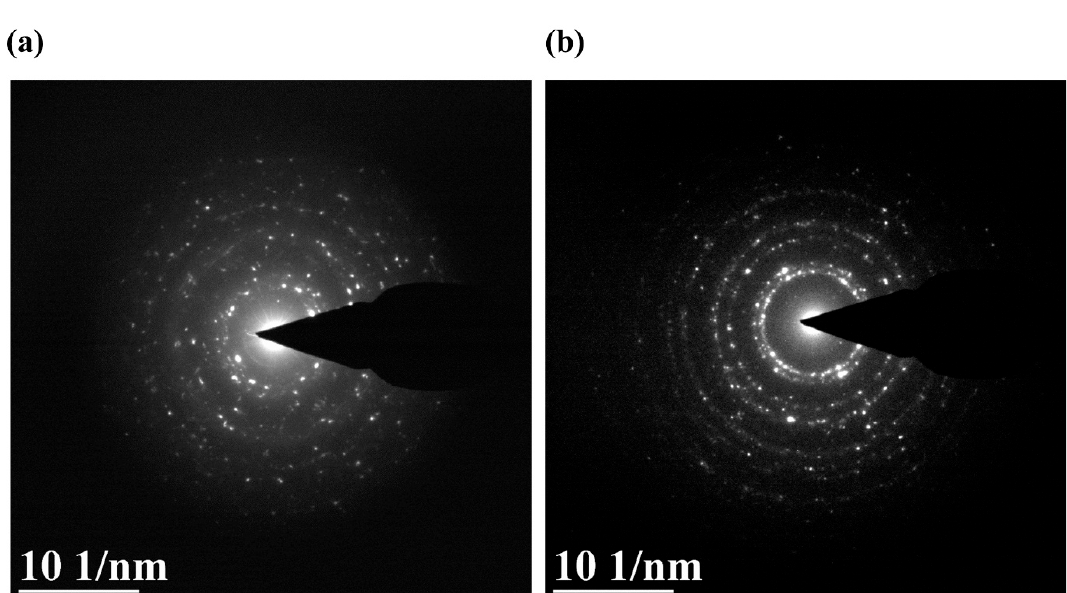
Figure 4. Crystal diffraction pattern of AgNSs ( a ) before phase transfer and ( b ) after phase transfer